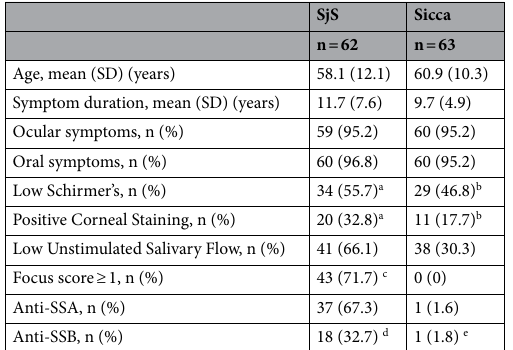
memory B-cells’ in SjS (50 vs 66 cells/µl, p = 0.021), more pronounced in the CD19 + IgD + CD27 + unswitched